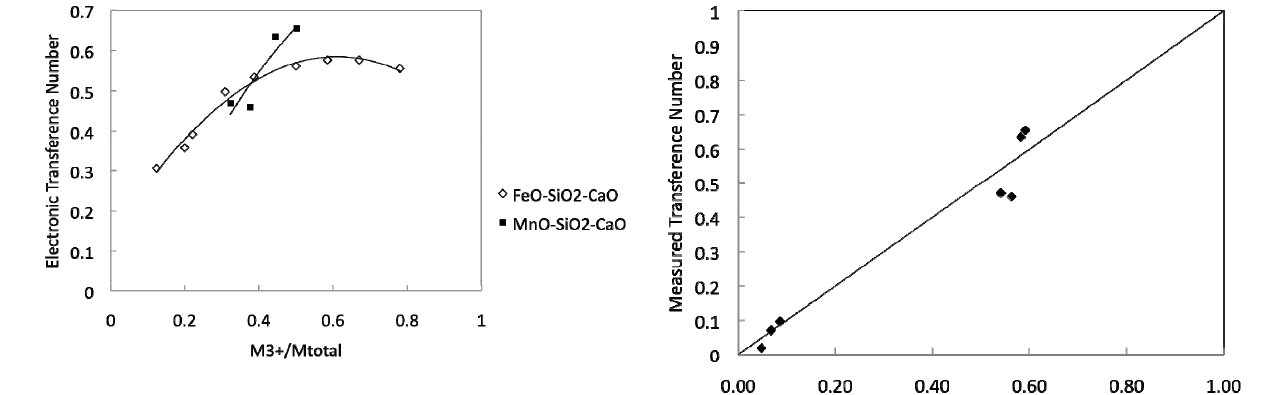
Figure 6. Transference number results obtained at 1773 K, for MnO-CaO-SiO 2 melts.